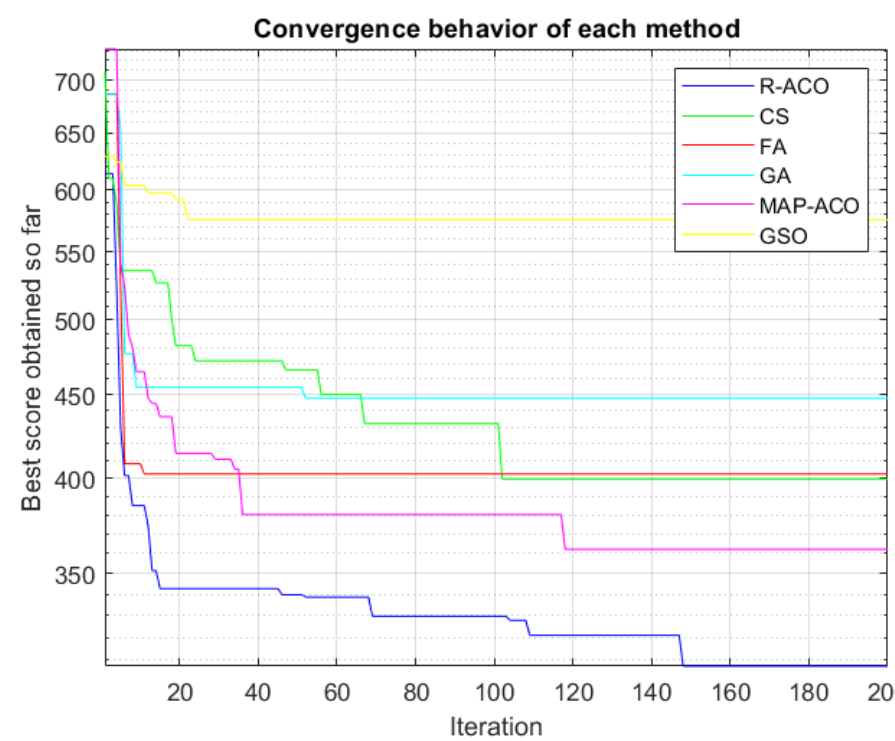
Figure 6. Convergence behavior of each method.